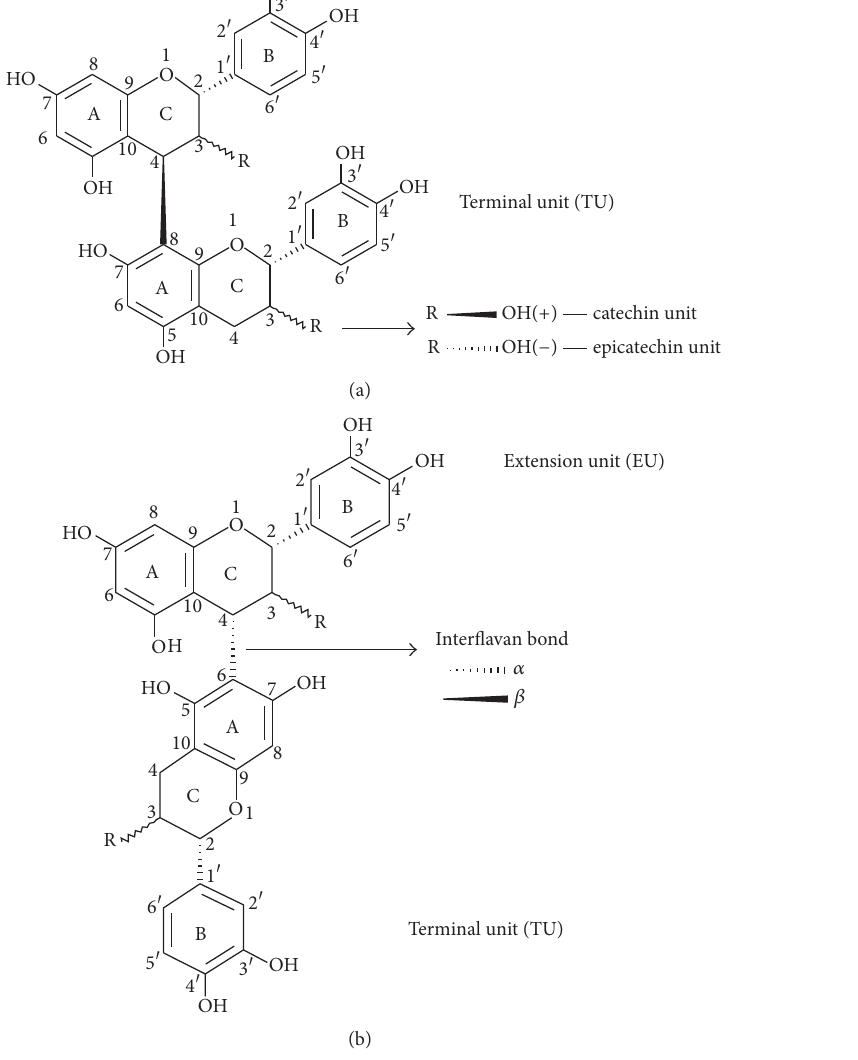
Figure 1: General structure of procyanidin dimers with interflavan bond types C4–C8 and C4–C6. (a) PB3 (C4 𝛼 –C8, catechin); PB4 (C4 𝛼 – C8, catechin-epicatechin). (b) PB5 (C4 𝛽 –C6, epicatechin); PB6 (C4 𝛼 –C6, catechin); PB7 (C4 𝛽 –C6, epicatechin-catechin); PB8 (C4 𝛼 –C6,